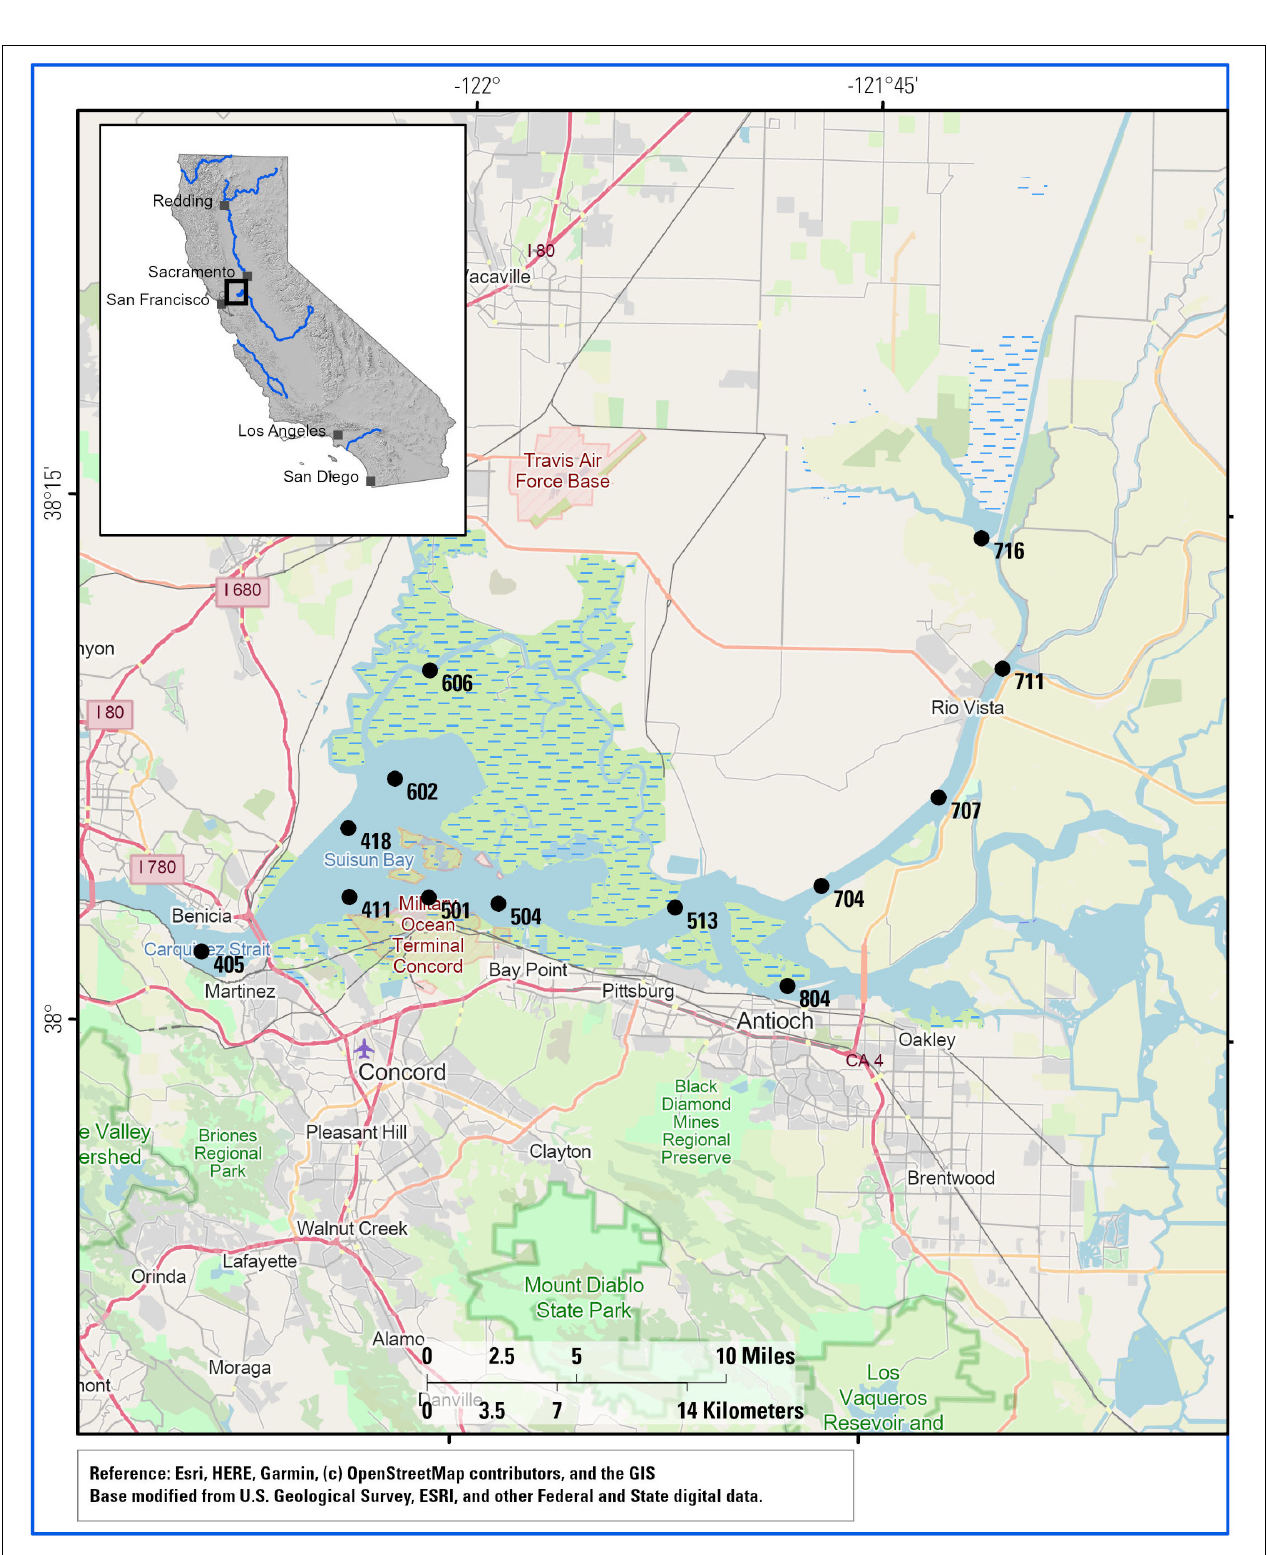
FIGURE 1 | Stations sampled in this study. Green shading with blue dashes indicates wetland areas. Station numbers correspond to the annual Fall Mid Water Trawl conducted by the California Department of Fish and Wildlife. The Sacramento Deep Water Ship Channel extends NNE from station 716 while the mainstem Sacramento River enters the Delta at station